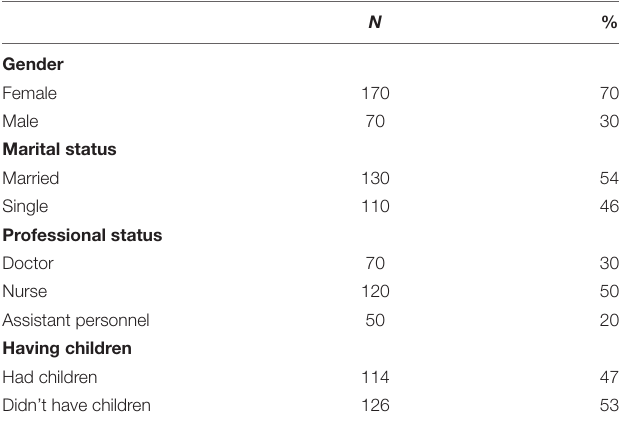
TABLE 5 | Correlation values of the relationship between stress, trait anxiety, burnout levels, and quality of life of healthcare professionals. N